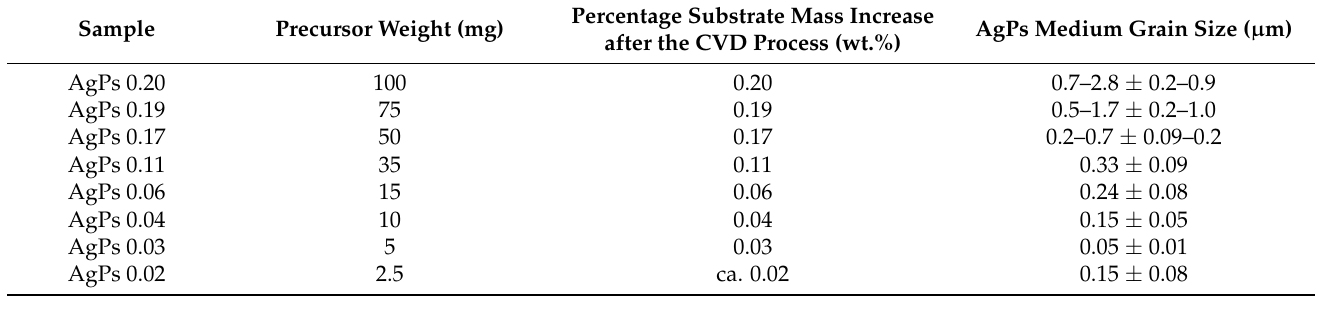
Figure 1. SEM images of AgPs films deposited on the surface of stainless steel (H17) substrates using CVD technique. Table 2. AgNPs films deposited by CVD technique.